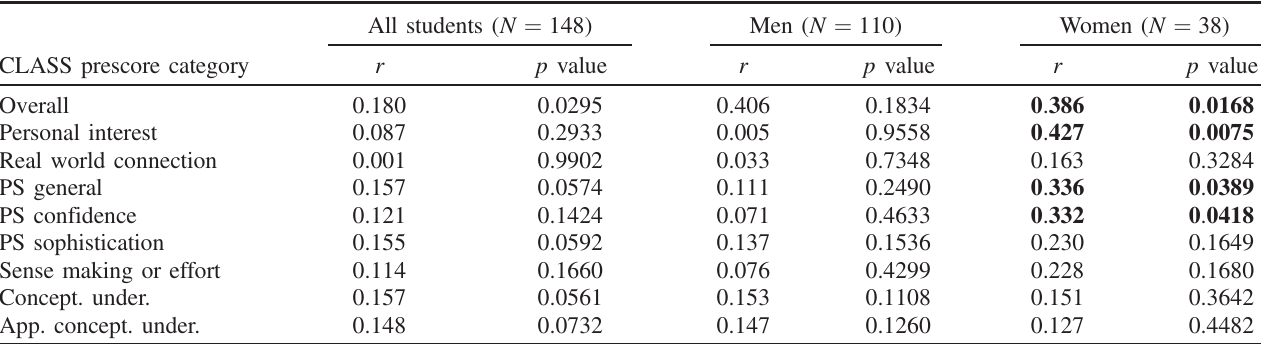
TABLE VII. Correlation of the normalized FCI gain and CLASS prescores, separated by category, for all students, men, and women. The regression coefficient r and the p value are given.